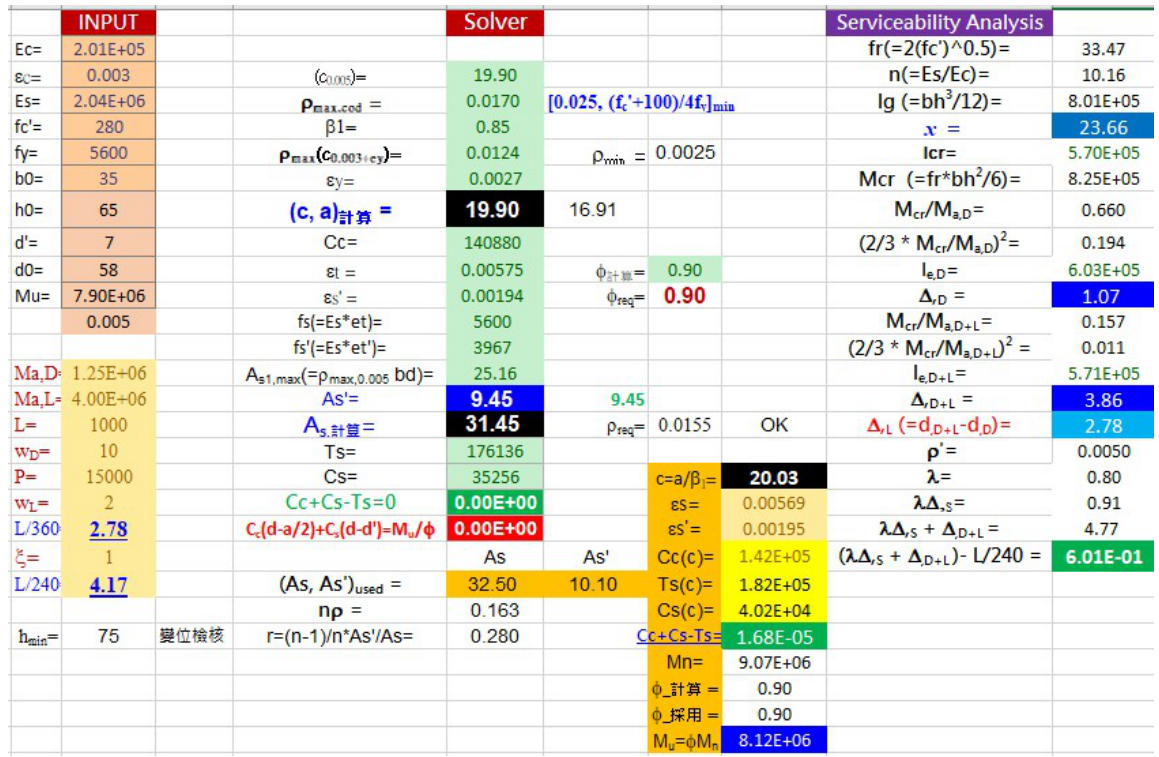
Fig. 6. Excel-spreadsheet modeling of RC beam design (in cm-kg metric units)